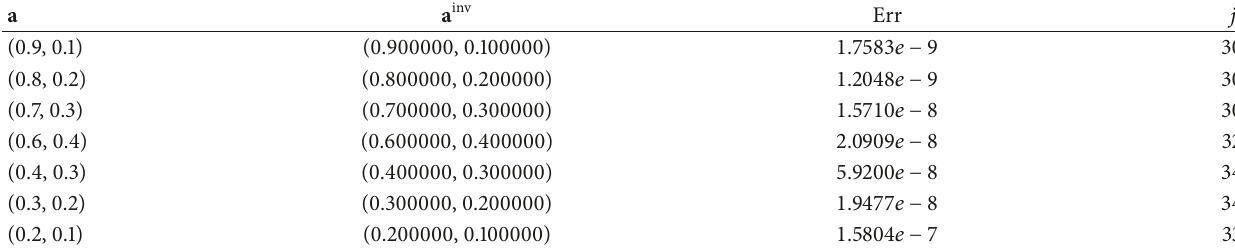
Table 1: The inversion results with different fractional orders for 𝑆 = 1